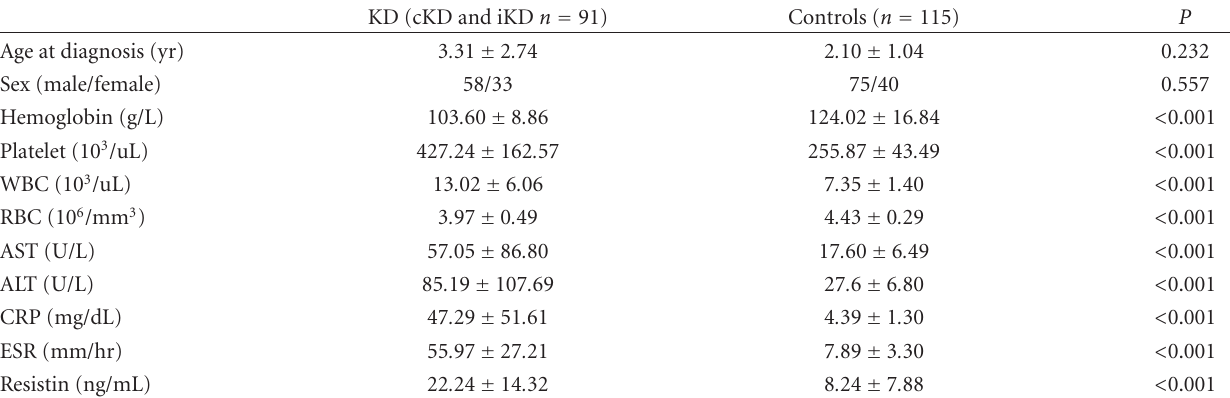
Table 1: Comparison of laboratory characteristic of patients and control groups.